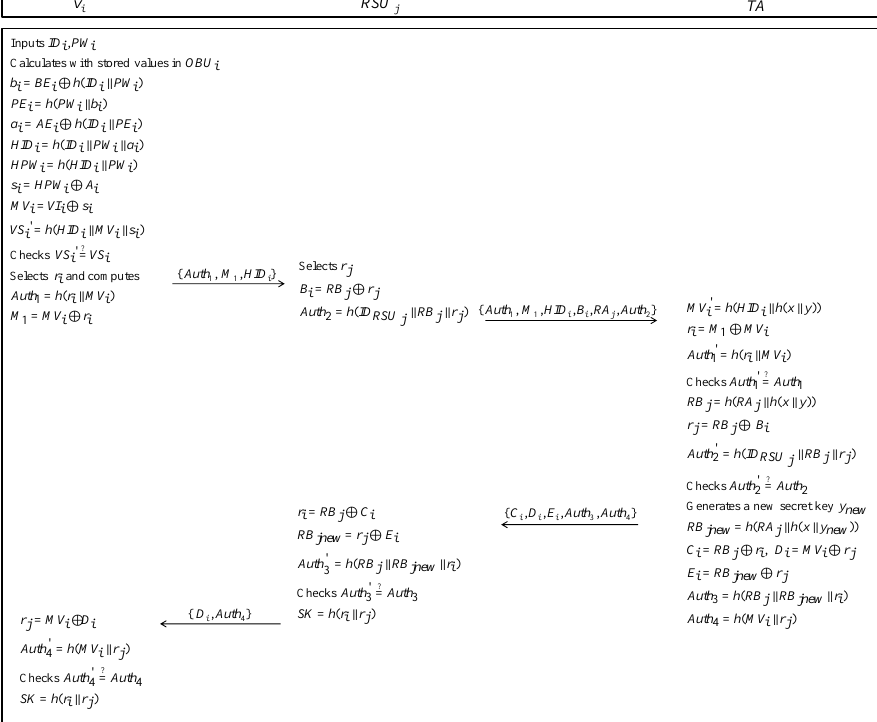
Figure 6. Key agreement and authentication phase of our proposed